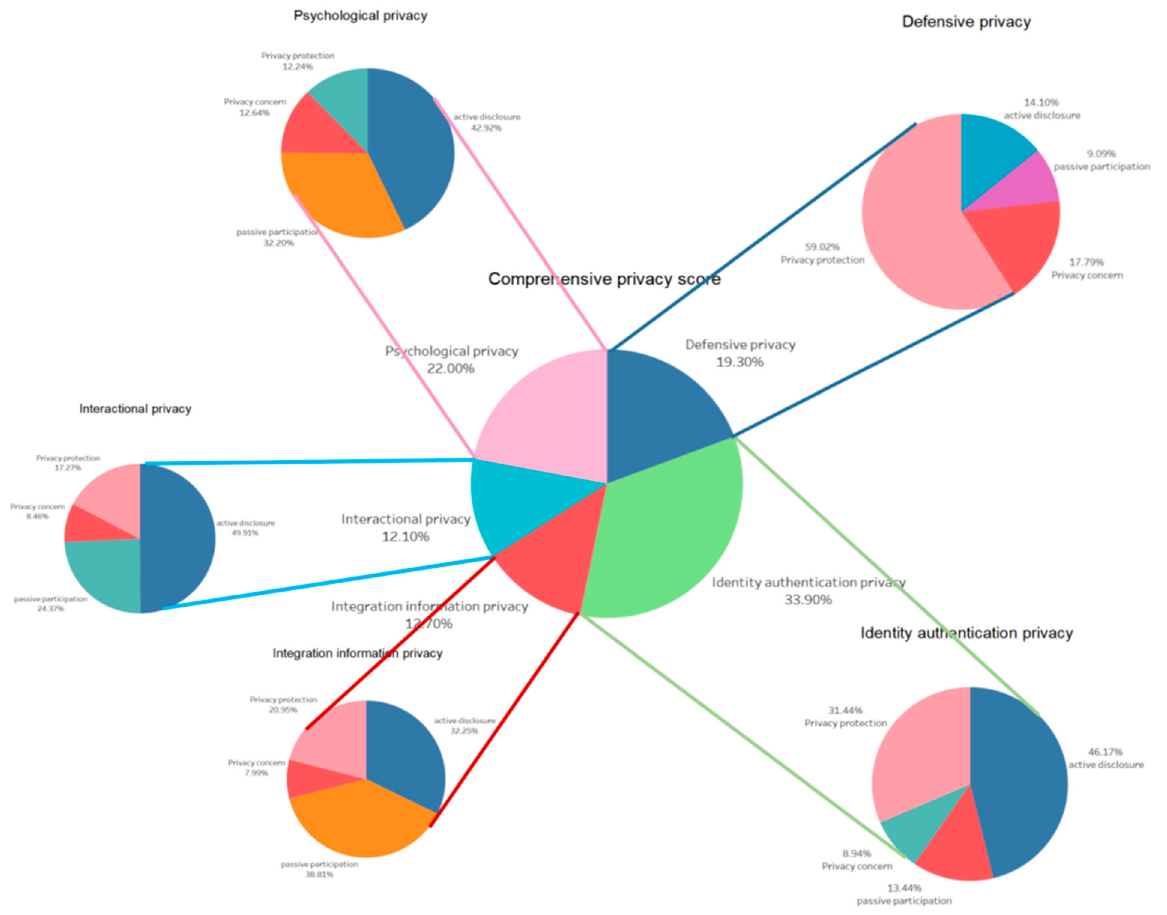
Figure 4. Single-level weight graph.